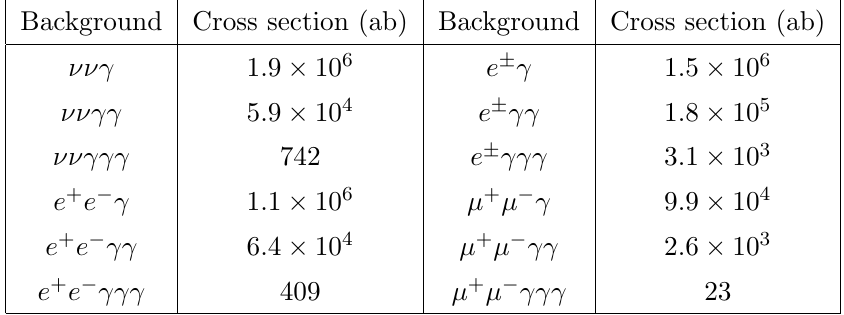
Table 2 . Major backgrounds to mono-photon searches that we consider. The cross sections (aver- aged over polarisations) are given for relatively mild cuts: p (cid:13) on any other particles in the detector volume with p T > 10